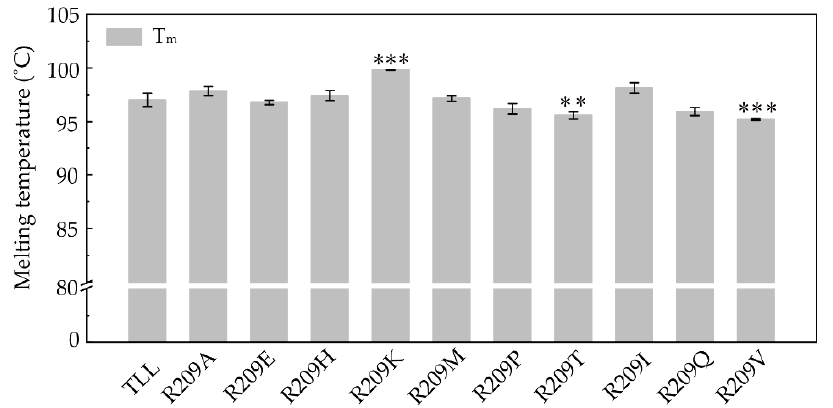
Figure 4. Melting temperatures (T m ) of TLL and ten R209 mutants. R209 mutants with two and three stars indicate the differences in T m values are significant at the 0.01 and 0.001 levels, respectively.